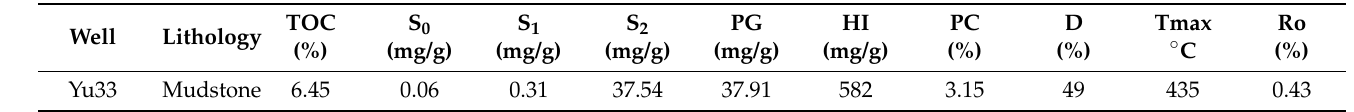
Table 1. Basic geochemical data of simulation-experiment